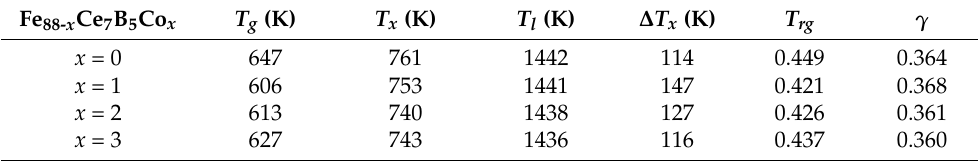
Table 1. The thermal properties of the Fe 88- x Ce 7 B 5 Co x ( x = 0, 1, 2, 3) amorphous ribbons